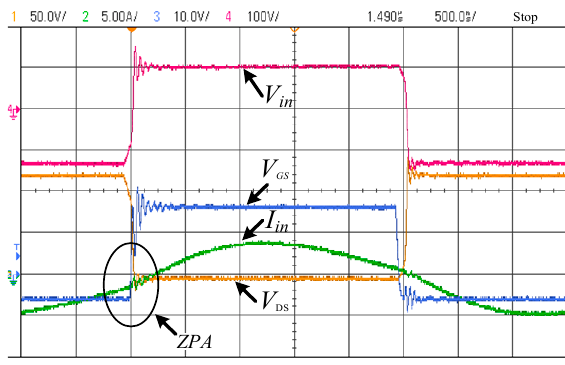
Figure 8. Experimental waves of V in , I in , V DS , V GS .